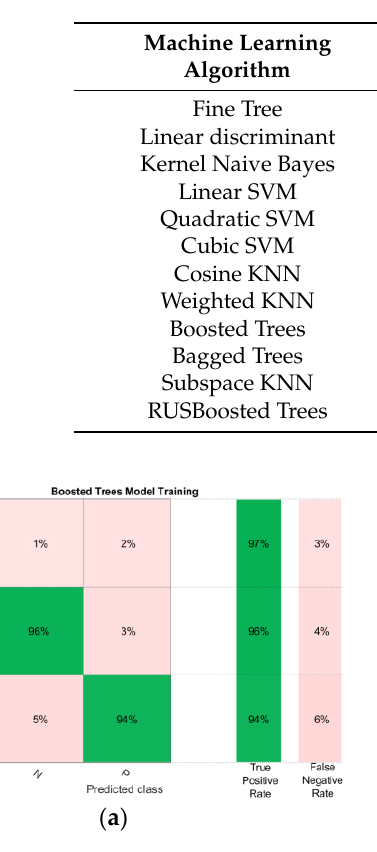
Table 2. Comparison of the obtained results after applying different machine learning algorithms using the whole predictor space and only the predictor space corresponding to the EEG signal features of the ear.